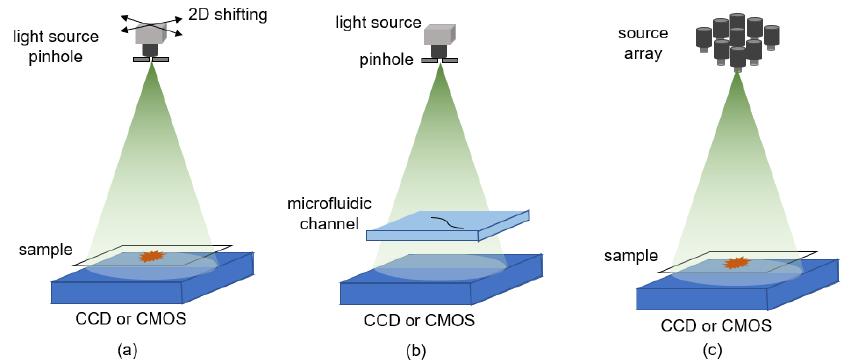
Figure 5. Pixel super-resolution schematic. ( a ) Source shifting. ( b ) Sample shifting. ( c ) Equivalent to source shifting.